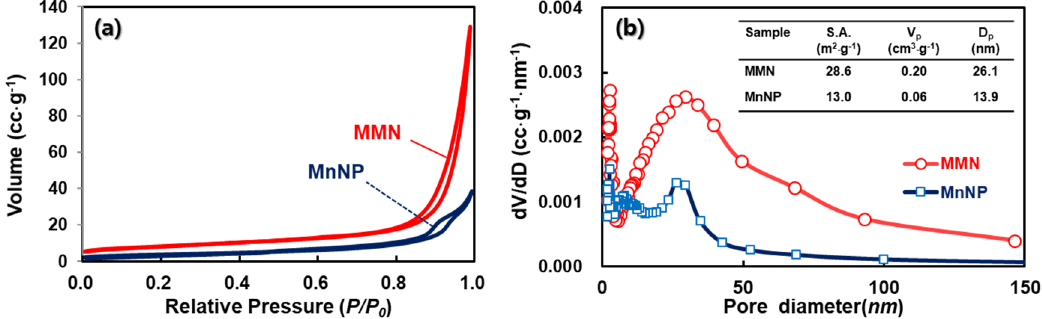
Figure 4. ( a ) Nitrogen adsorption–desorption isotherms, and ( b ) Barrett − Joyner − Halenda (BJH) pore size distributions of MMN and MnNPs (inset shows the surface area (S.A.), total pore volume (V p ), and average pore diameter (D p ) of MMN and MnNPs).